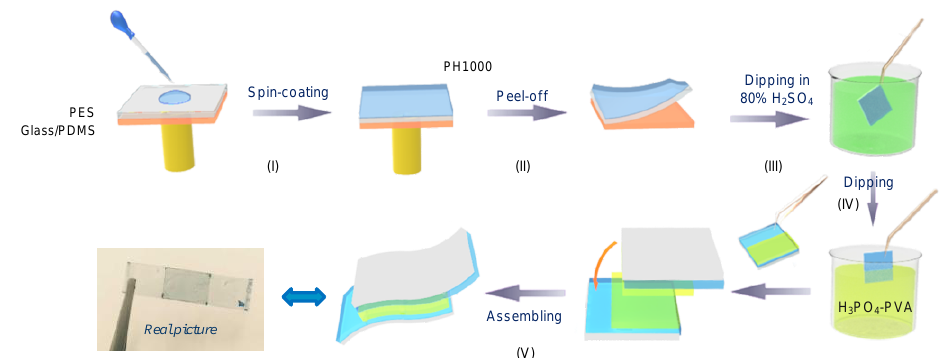
Figure 1. Schematic diagrams for the preparation of the S-PH1000 electrode and the flexible semi-transparent supercapacitor. Firstly, the PH1000 solution was spin-coated on PES substrate where the polyethersulfonate (PES) substrate was attached to a rigid glass substrate with a polydimethylsiloxane (PDMS) sheet in between. After spin coating, the PES/PH1000 film was peeled-off from the glass/PDMS substrate and heated on a hot plate. Then, the sample was immersed into an 80 wt.% H 2 SO 4 solution at different temperatures to enhance the conductivity. After that, the S-PH1000 electrode was dipped into H 3 PO 4 -PVA glue and two pieces of electrodes were assembled to form a flexible semi-transparent supercapacitor. The last picture is the digital photograph of the semi-transparent flexible supercapacitor based on S-PH1000 films.